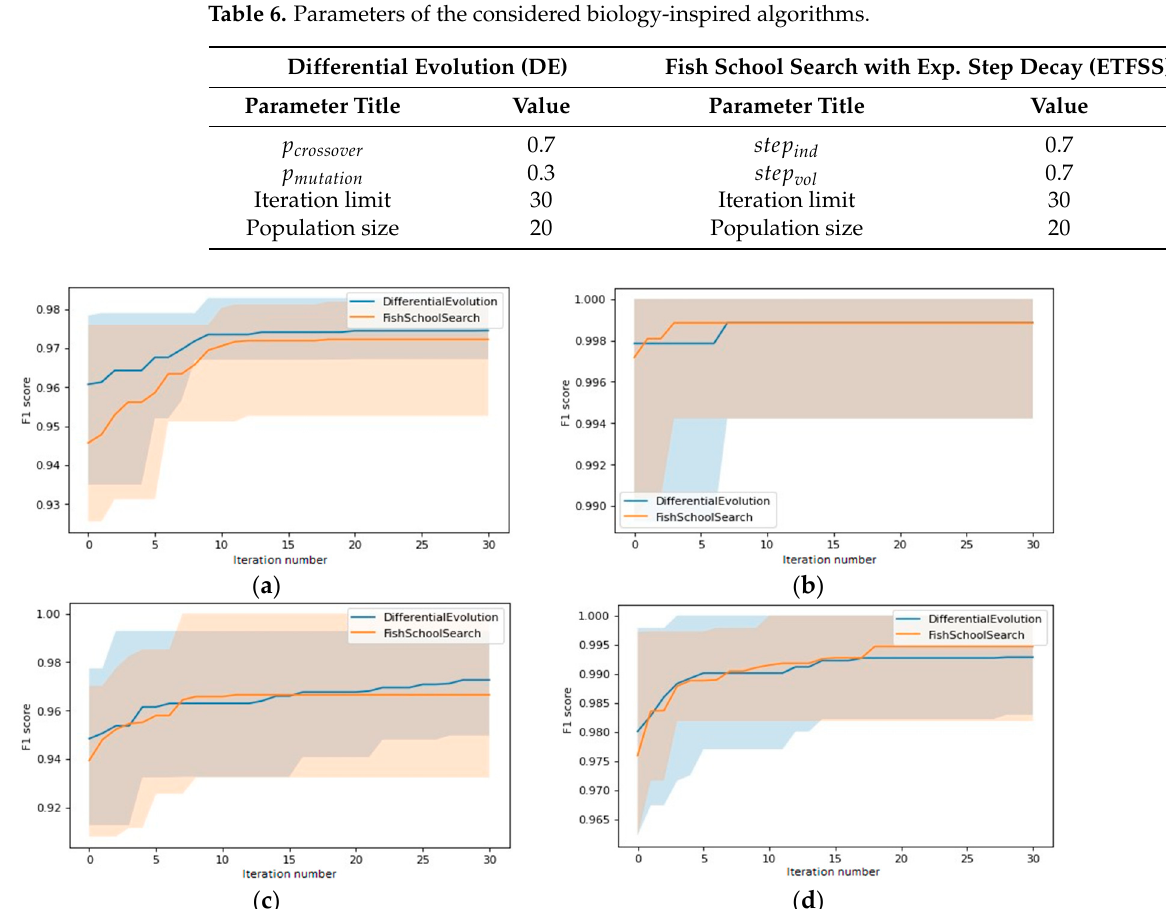
Figure 6. Convergence of the considered biology-inspired algorithms DE and ETFSS optimizing the macro f1 score (10) in testing part of the dataset containing program texts solving automatically generated tasks of various types (see Table 1): ( a ) type 8; ( b ) type 9; ( c ) type 10; ( d ) type 11.